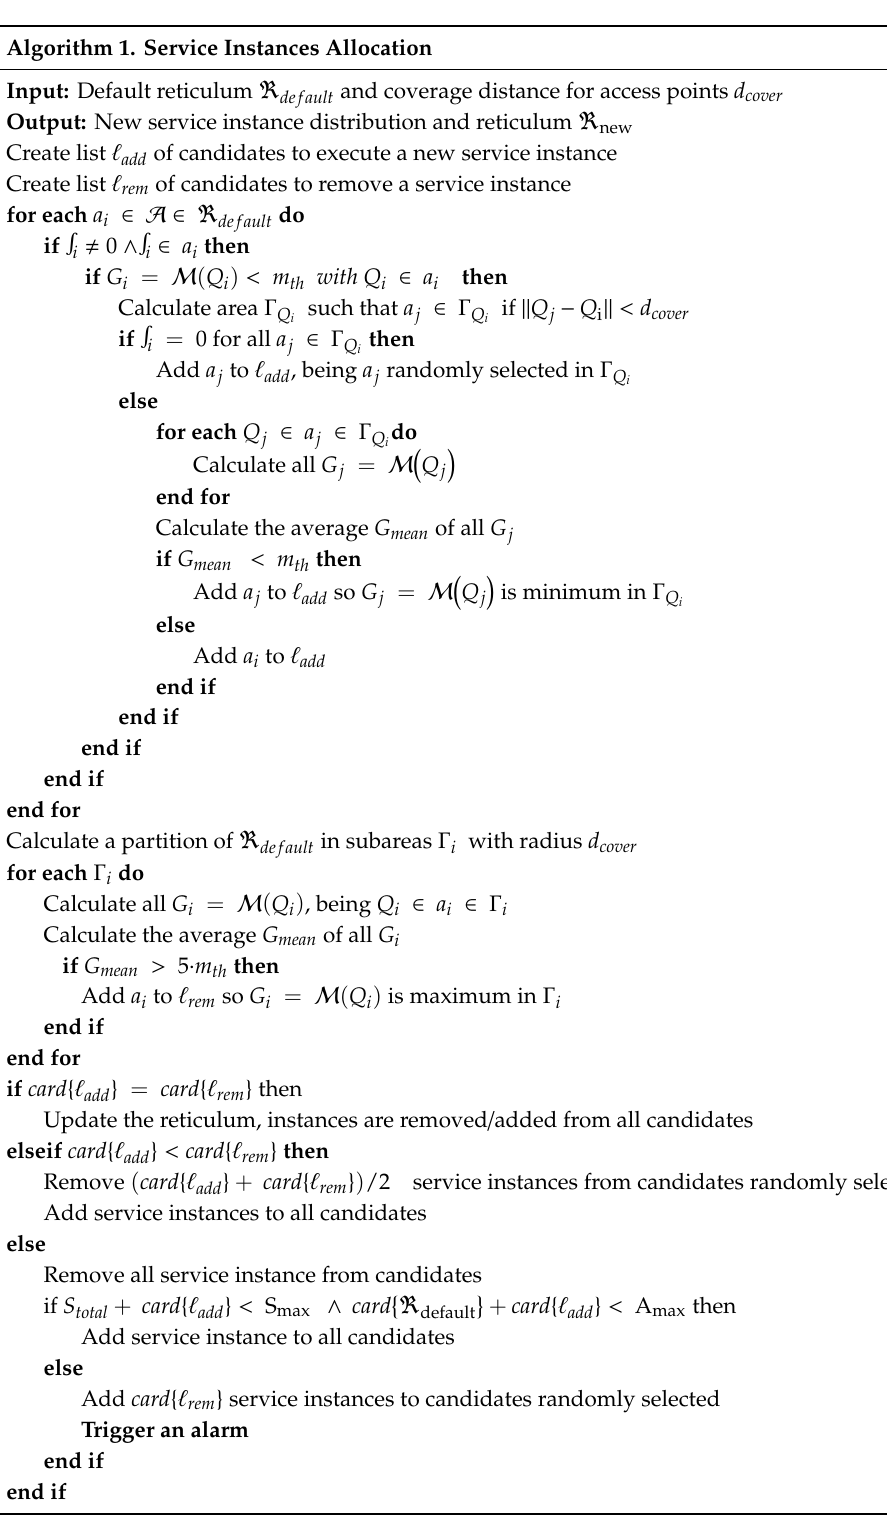
Algorithm 1. Service Instances